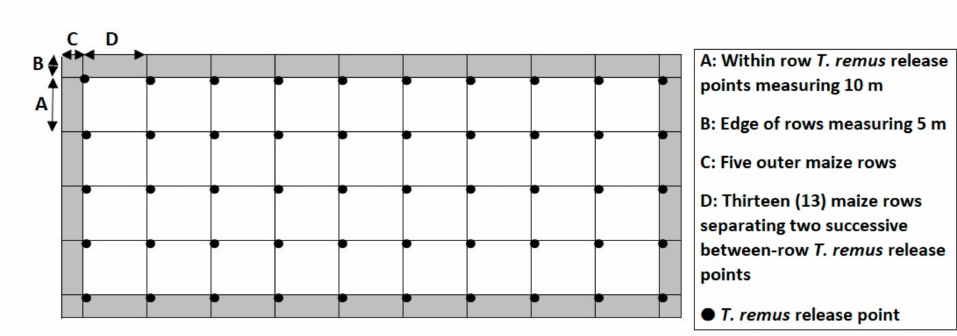
Figure 2. Scheme showing the 50 Telenomus remus release points in 0.5 ha maize plots with distances of 10 m within rows and 10.4 m between rows.